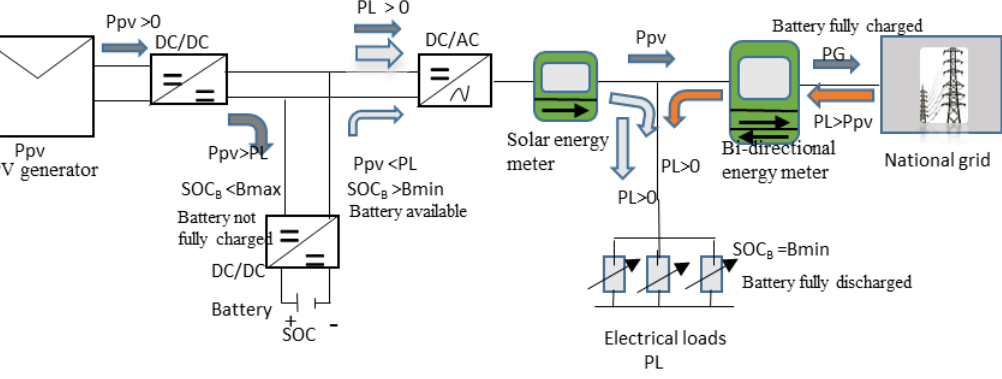
Figure 9. Schematic representations of the PV system with integration in the utility grid. Adapted from [106] .